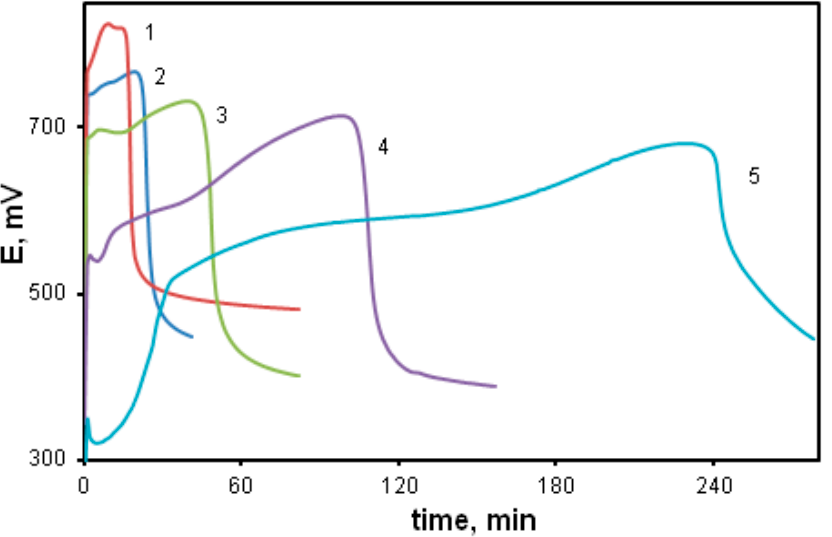
Figure 4. Changes in redox potential with time at the oxidation of DADCB in various media: [HCl] = 0.5 (1), 0.1 (2), 0.02 mol/L (3); water (4); [NH 4 OH] = 0.05 mol/L (5).